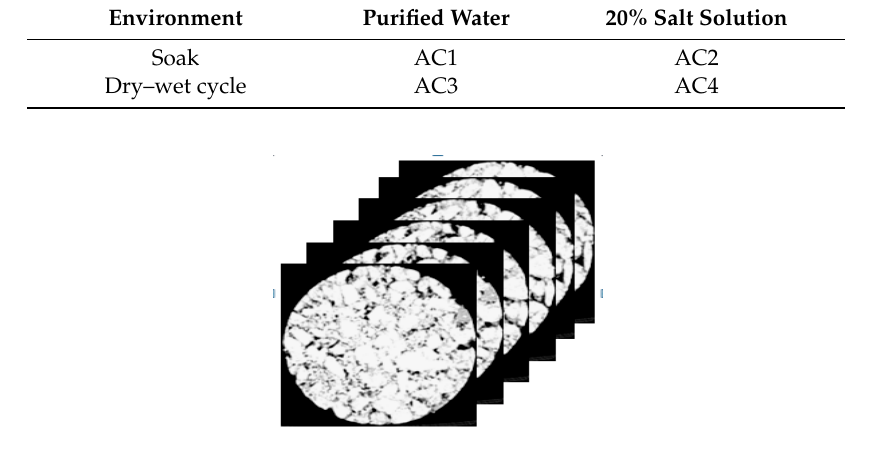
Table 6. Test Environment for Specimens’ CT Scanning.